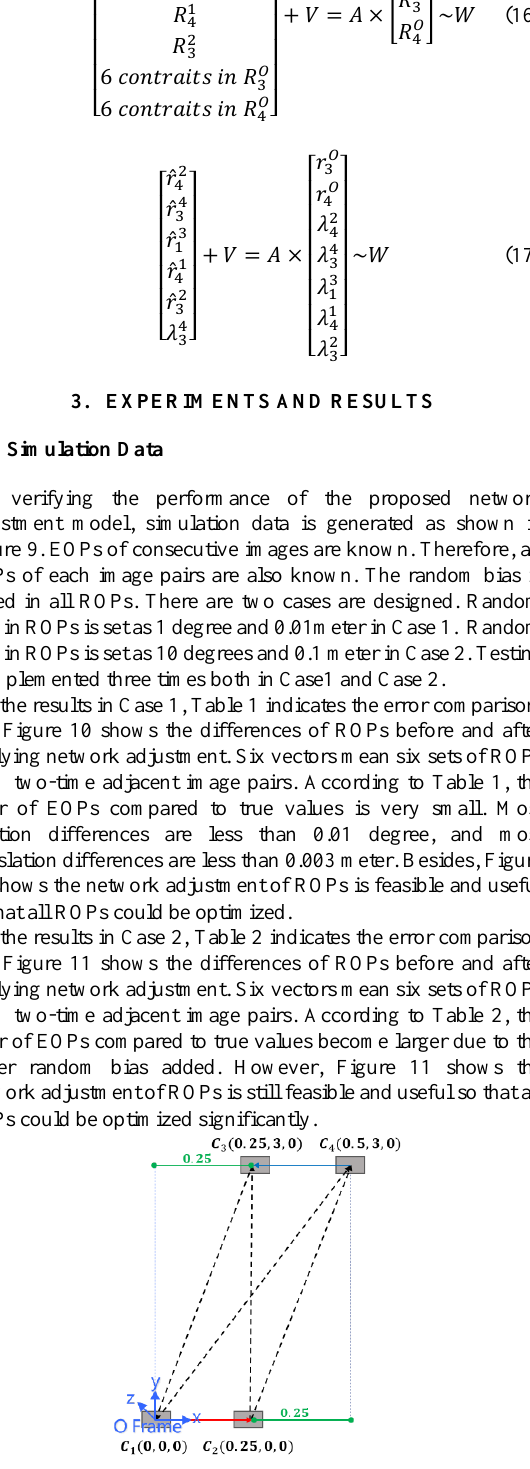
Figure 9. Simulation data of consecutive